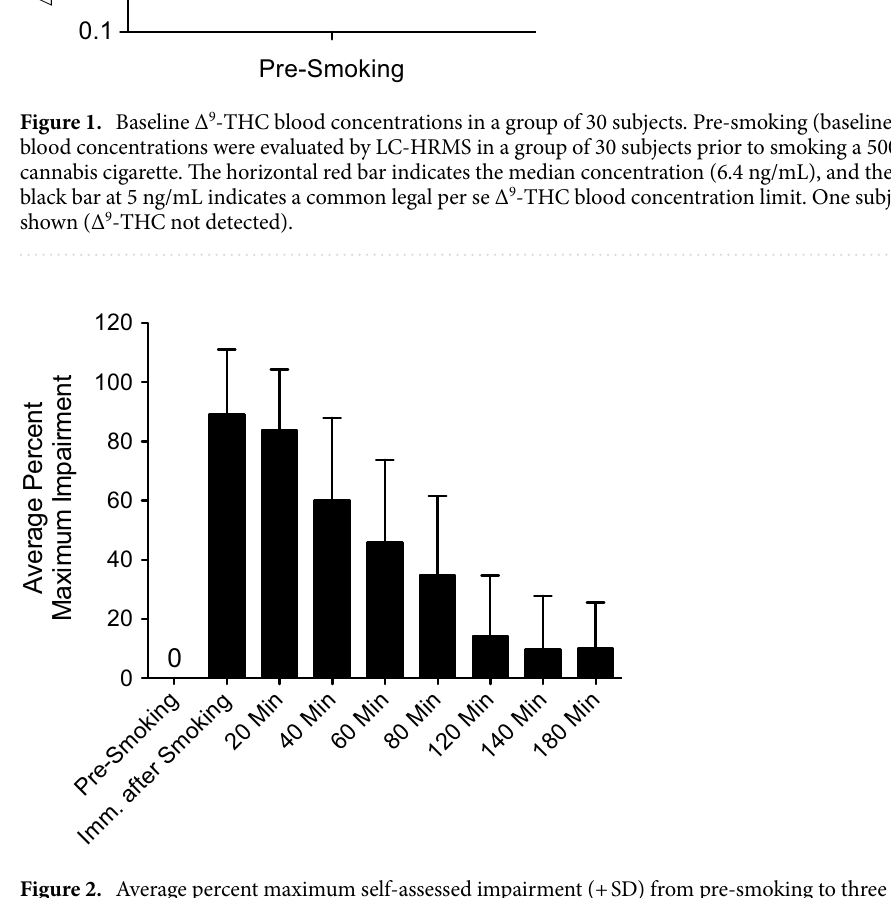
Figure 2. Average percent maximum self-assessed impairment (+ SD) from pre-smoking to three hours post- smoking ( N = 74). For each subject, impairment data were expressed as a percentage relative to the individual subject’s maximum self-reported impairment